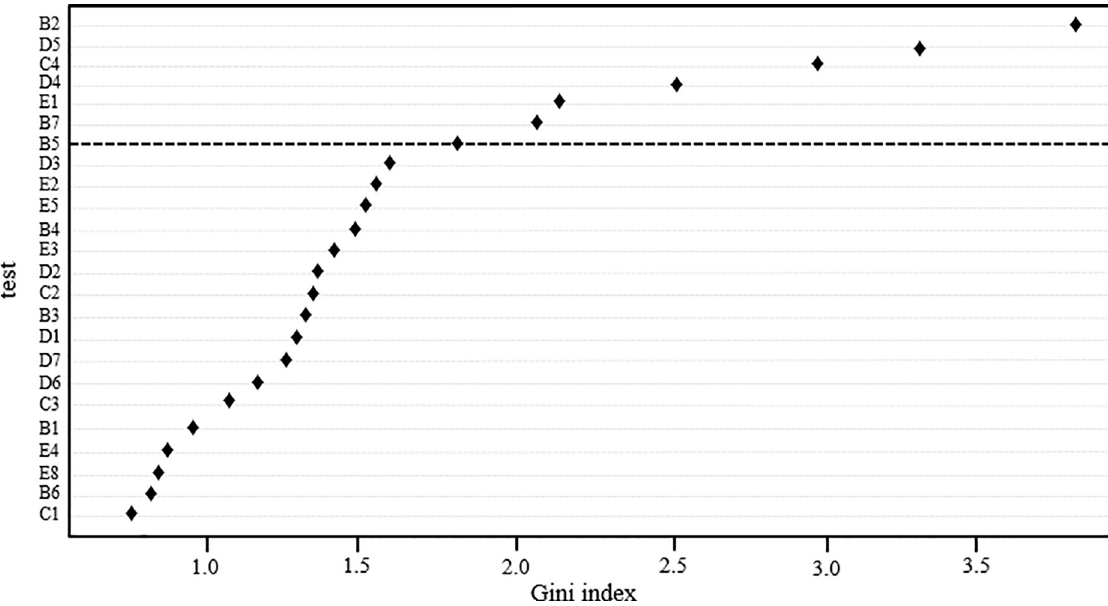
Fig 3. Importance of particular variables in differentiating the groups of successful and less successful wrestlers.